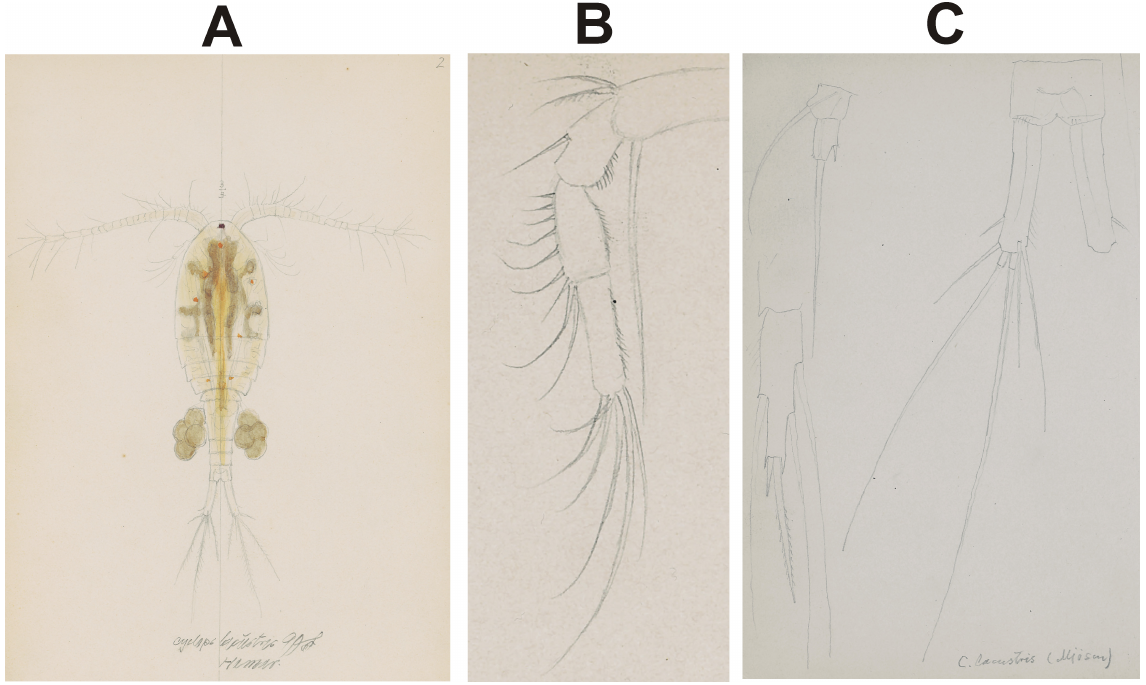
Fig. 10. original drawings of Cyclops lacustris , made by G.o. sars (archives of the national